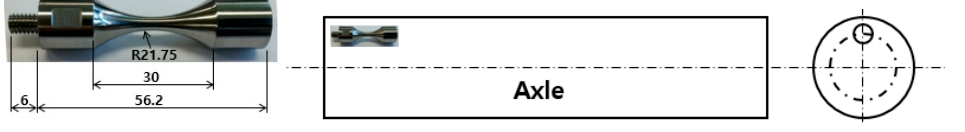
Figure 2. Microstructures of the axle material.